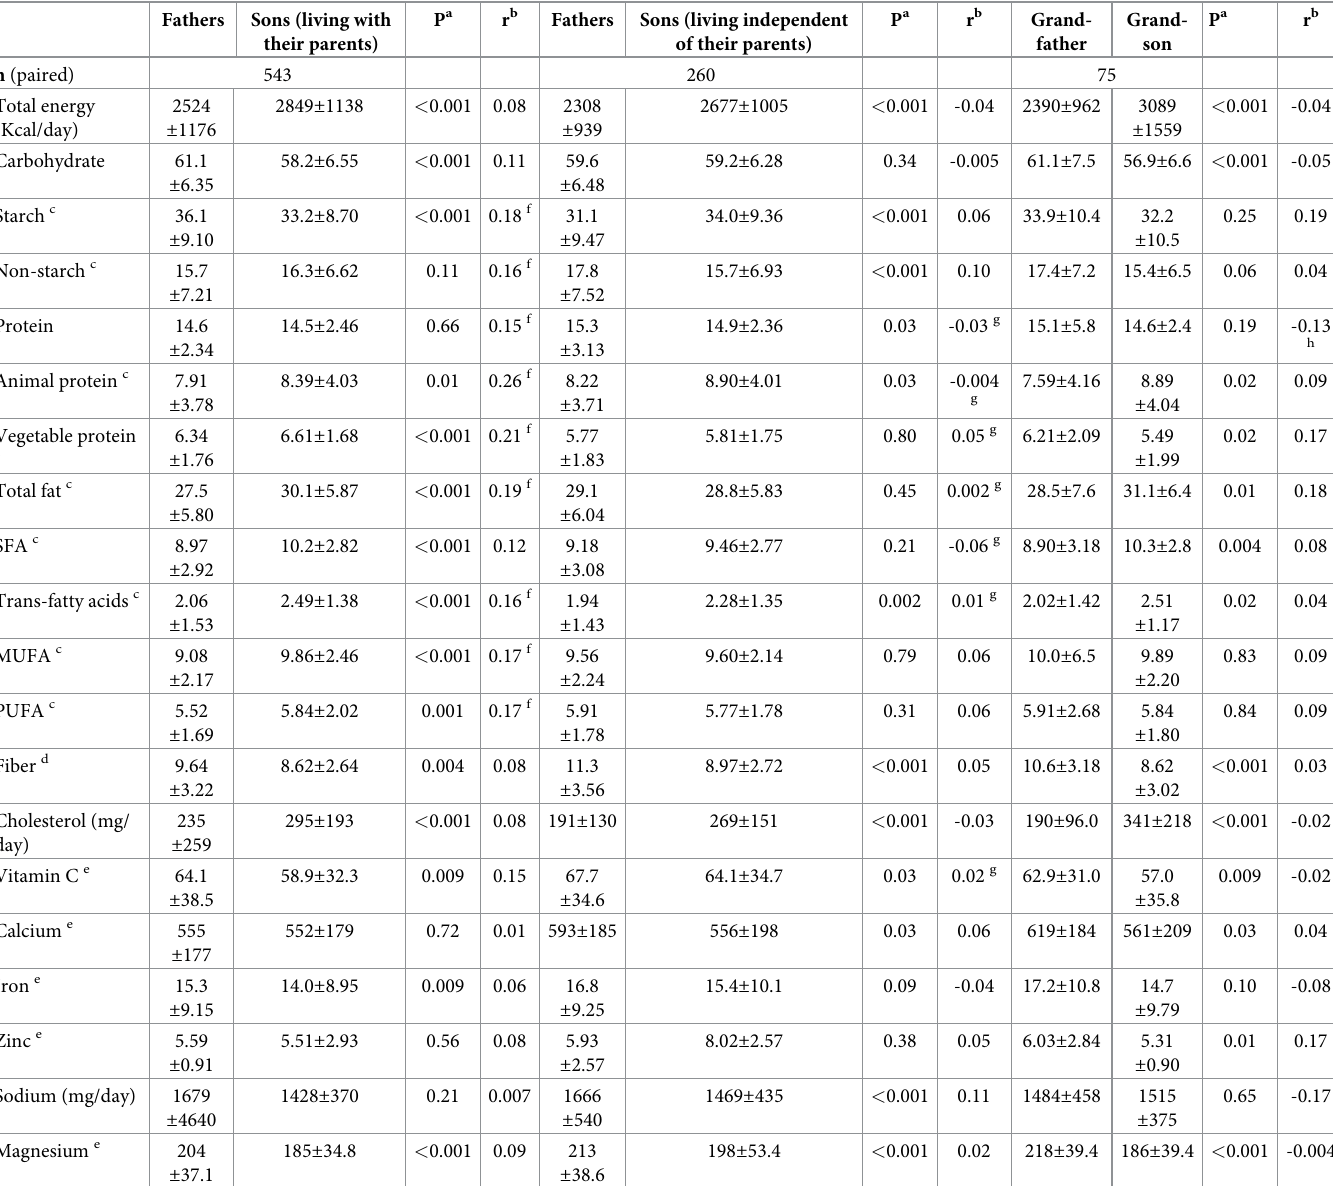
Table 2. Total energy and nutrient intakes of 3 generations of participants (fathers-sons) by living status.